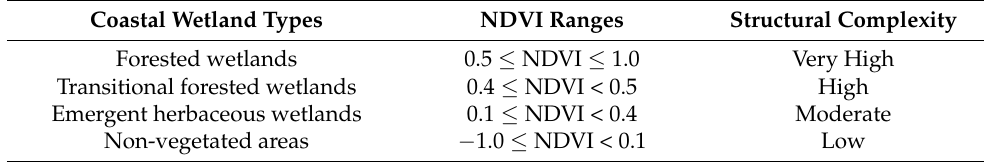
Table 1. NDVI ranges and structural complexity of different coastal wetland types. Coastal Wetland Types NDVI Ranges Structural Complexity Forested wetlands 0.5 ≤ NDVI ≤ 1.0 Very High Transitional forested wetlands 0.4 ≤ NDVI < 0.5 High Emergent herbaceous wetlands 0.1 ≤ NDVI < 0.4 Moderate Non-vegetated areas − 1.0 ≤ NDVI < 0.1 Low